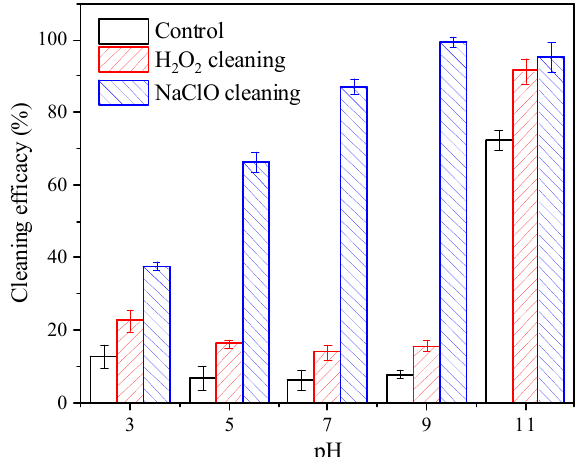
Figure 2. E ff ects of pH on cleaning e ffi cacy of H 2 O 2 and NaClO for ultrafiltration (UF) membranes fouled by humic substances (HS). C (H 2 O 2 ) T = C (NaClO) T = 500 mg / L, with pure water as control, and pH was adjusted by adding HCl or NaOH; cleaning time 6 h.